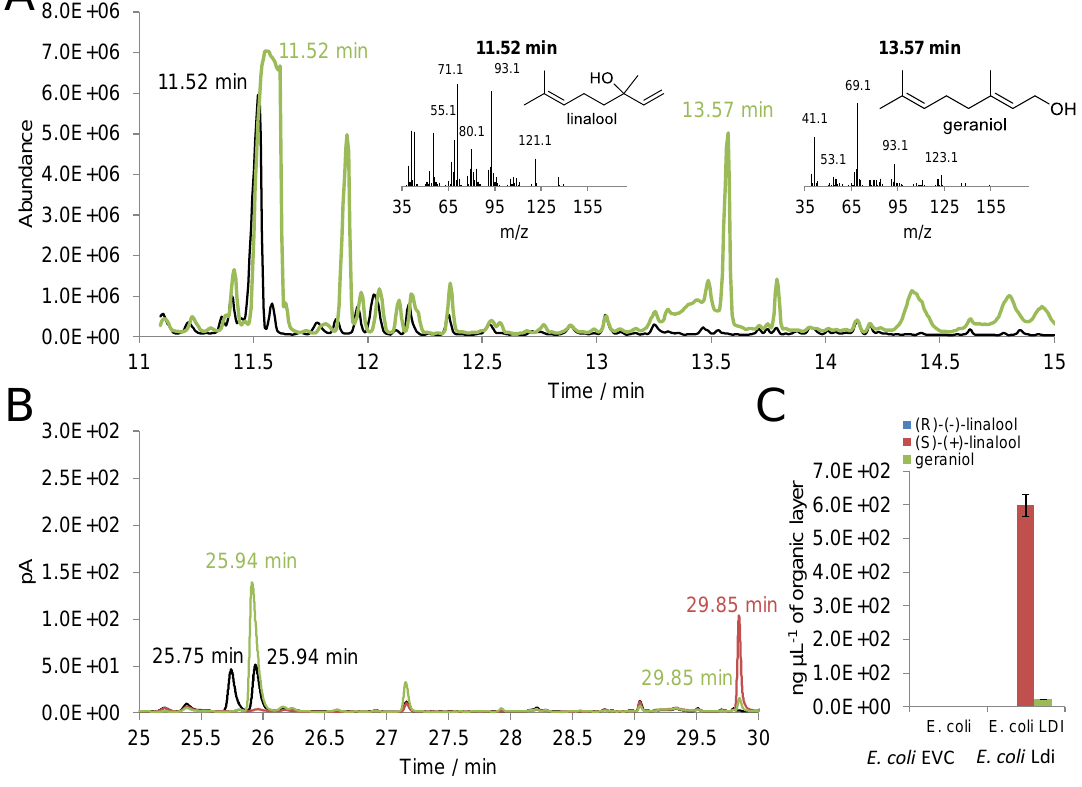
Figure 2. Whole-cell biotransformation of β -myrcene with E. coli expressing Ldi confirms enzyme activity. ( A ) GC-MS of an authentic standard of racemic linalool standard (black) and a representative sample from the biotransformation (green). ( B ) Chiral GC-FID of authentic racemic linalool (black) and geraniol (red) standards and a representative sample from the biotransformation (green). ( R )-( − )-linalool and ( S )-( + )-linalool were identified on basis of earlier publications [2,3] which showed that only the S -enantiomer of the tertiary alcohol is formed by Ldi. ( C ) Quantification of β -myrcene conversion to ( S )-( + )-linalool and geraniol by an E. coli empty vector control (EVC) and E. coli cells expressing the enzyme ( E. coli Ldi).